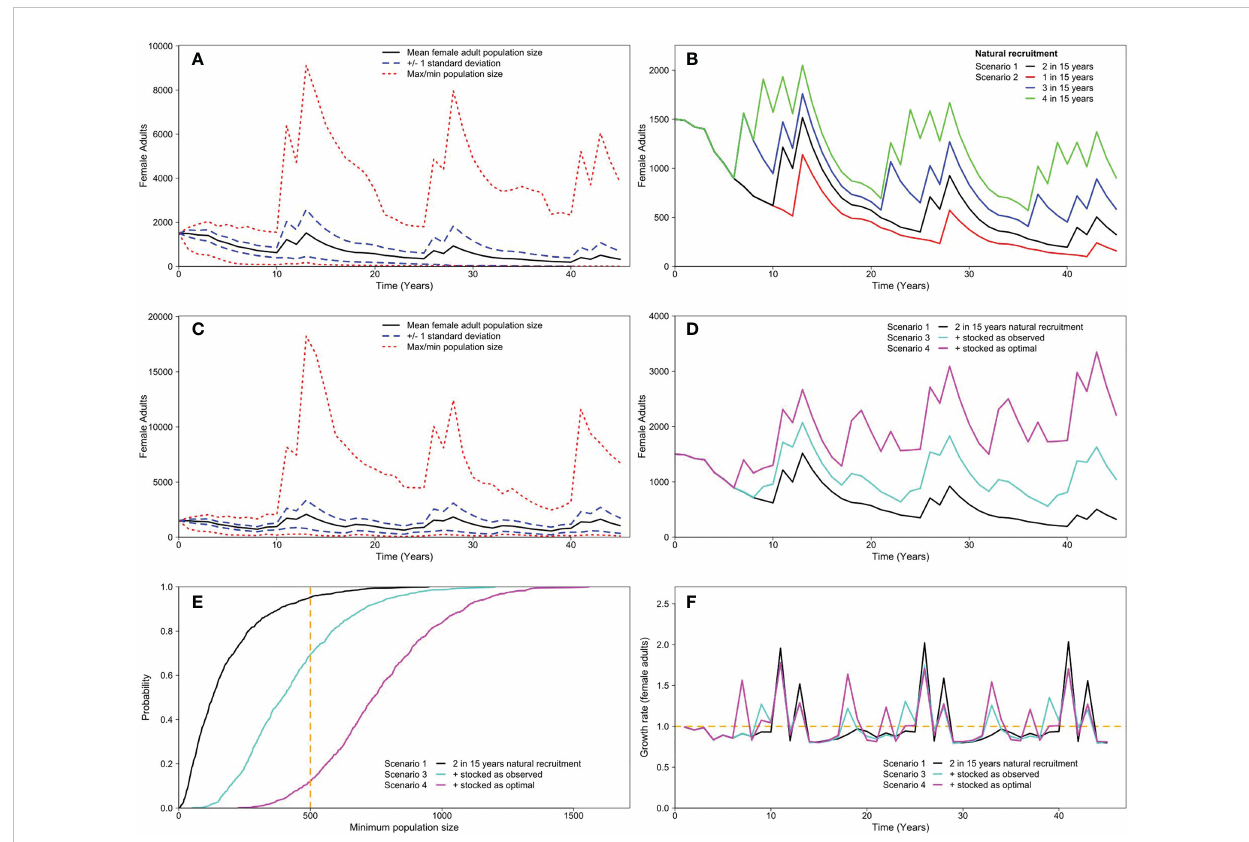
FIGURE 7 Summary of the modelled female Murray cod adult population trajectories in the Mitta Mitta River for (A) Scenario 1 - the observed thermal time series (2 in 15 years) for natural recruitment; (B) Scenario 2 - modi fi ed thermal time series for natural recruitment (Red: 1 in 15 years; Blue: 3 in 15 years; Green: 4 in 15 years) in comparison with Scenario 1; (C) Scenario 3 - the observed stocked and natural recruitment time series in the Murray cod population model for the Mitta Mitta River; (D) Scenario 1, Scenario 3 and Scenario 4 - the optimal stocked time series; (E) the associated risk curves for each of the scenarios presented in (D) with the vertical dashed line the threshold population size of 500 female adults and (F) the associated female adult growth rate to the scenarios presented in (D)